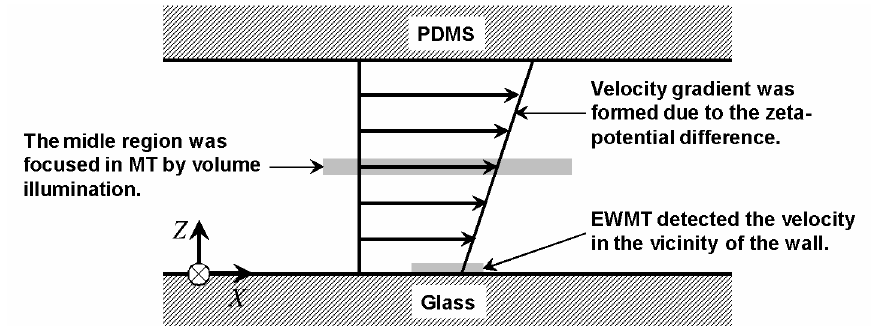
Figure 8. Schematic concept of EOF velocity distribution in the depthwise direction in the microchannel rinsed by the CMNB-caged fluorescein.